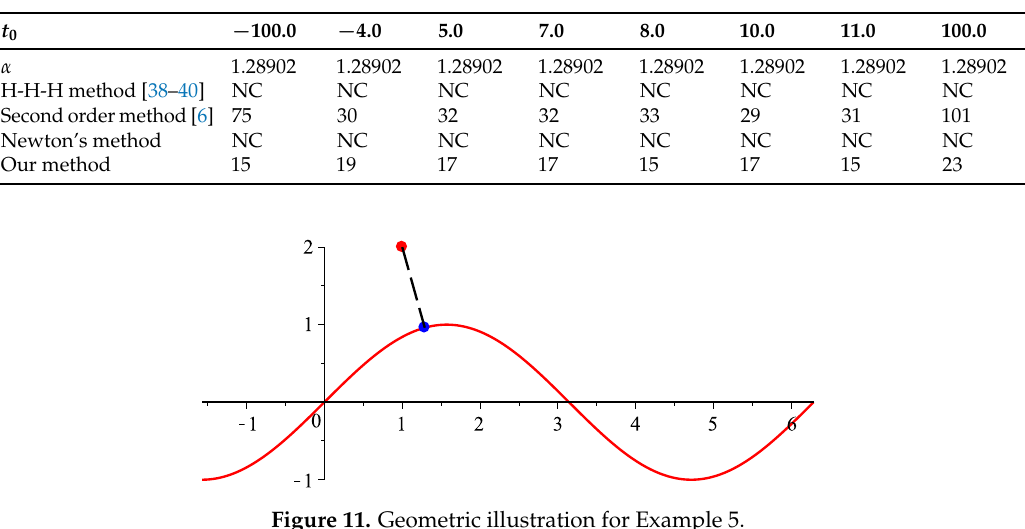
Table 13. Comparison of iterations by different methods in Example 5.